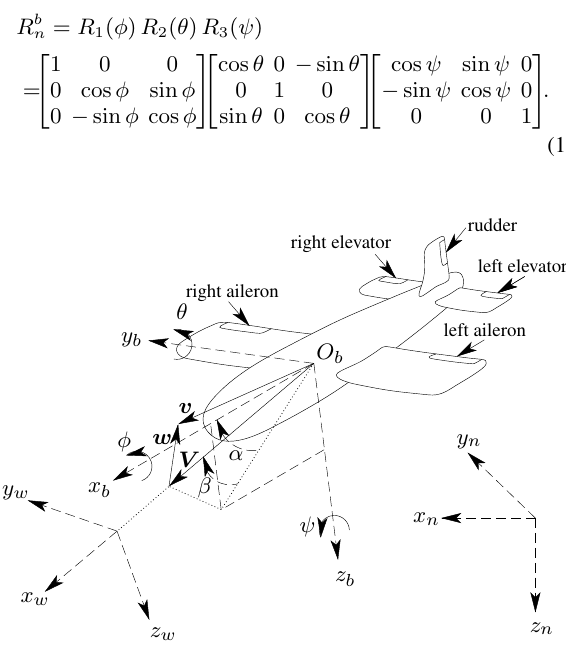
Figure 1: Navigation, body, and wind frames with airspeed ( V ), wind velocity( w ), and UAV velocity ( v ), as weel as roll ( φ ), pitch ( θ ), and yaw ( ψ )